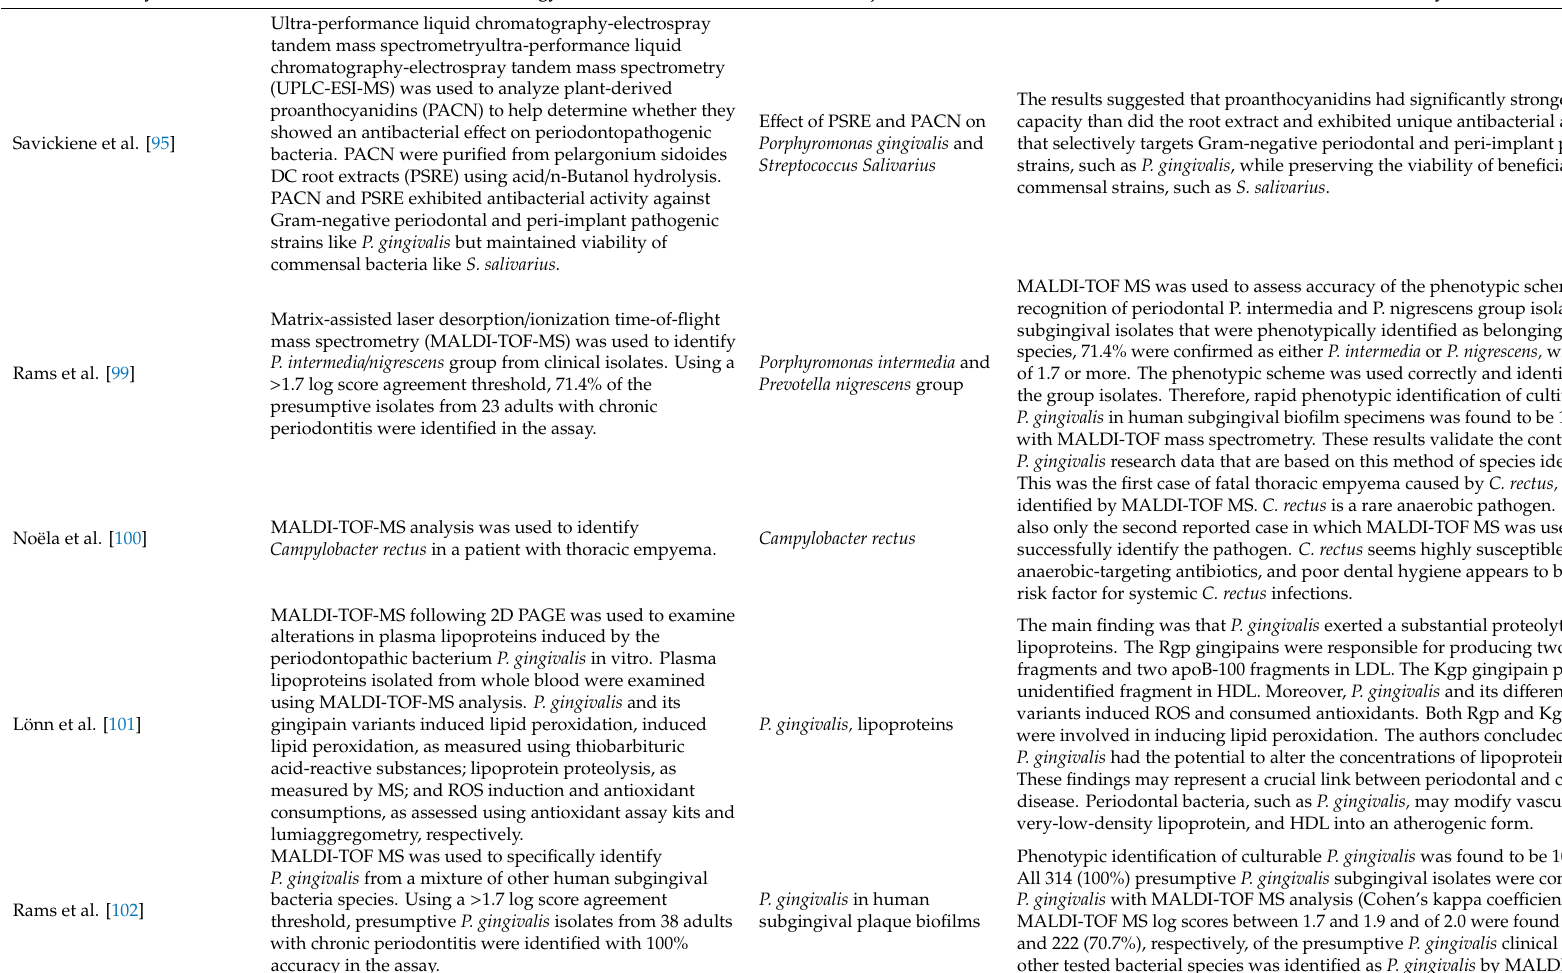
Table 2. Proteome Analyses of Molecular Events in Oral Pathogenesis of Virus Infection in GCF, Saliva, and Other Oral Components in Periodontal